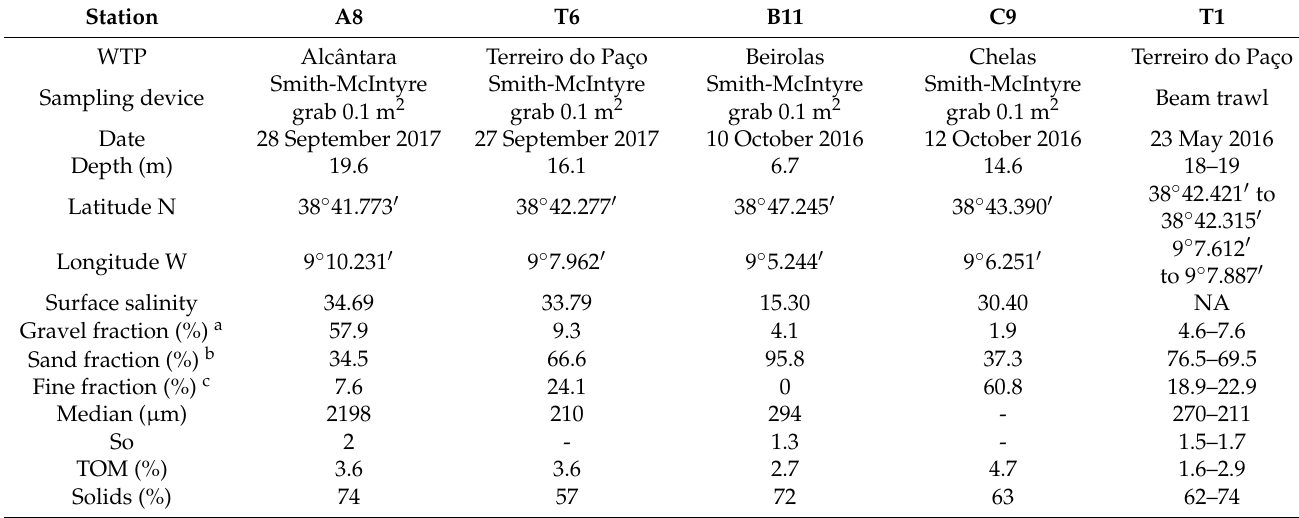
Table 1. Characterisation of the sampling stations of Pyromaia tuberculata in the Tagus estuary, Lisbon. Station